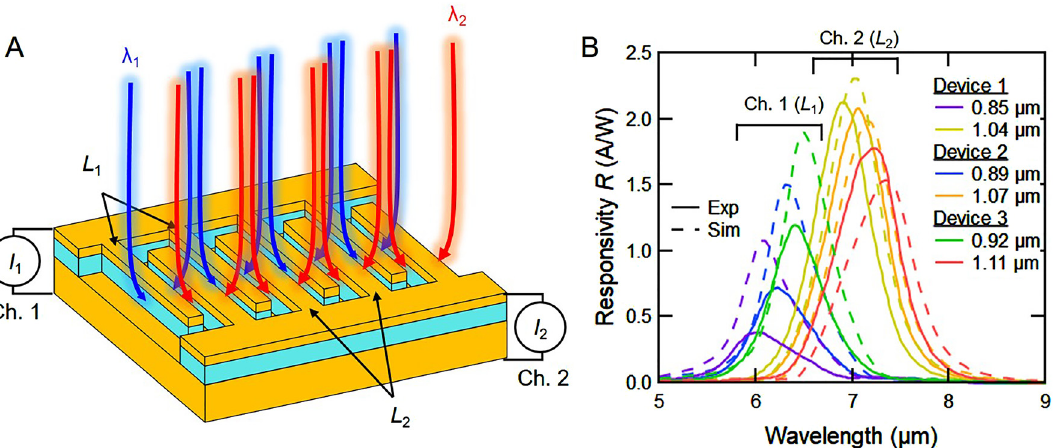
Figure2: A)Schematicofdeviceoperatingprinciple.Onedeviceconsistsoftwodetectors(Ch.1,Ch.2)generatingindependentphotocurrents ( I 1 , I 2 ), composed of electrically isolated interdigitated quantum well infrared photodetector (QWIP) stripes with different dimensions ( L 1 , L 2 ) selectively absorbingat their correspondingresonancewavelengths( λ 1 , λ 2 ). B) Experimentalandsimulatedunpolarizedresponsivityof QWIP stripes from three dual-band devices. Brackets indicate which detectors correspond to which output signal in a device.